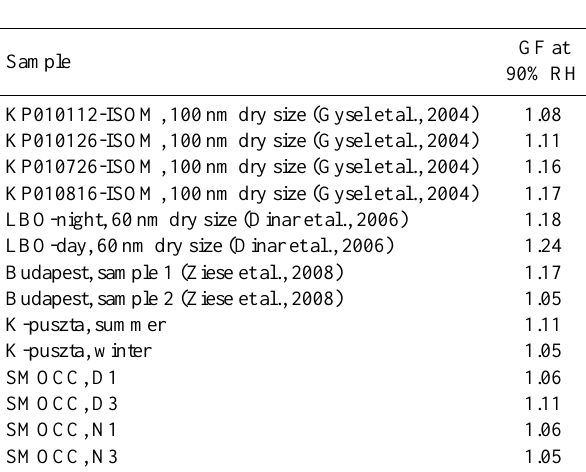
Table 2. Previously measured HULIS growth factors at 90% RH to- gether with the GFs from this study. Sample notations are according to the published papers.